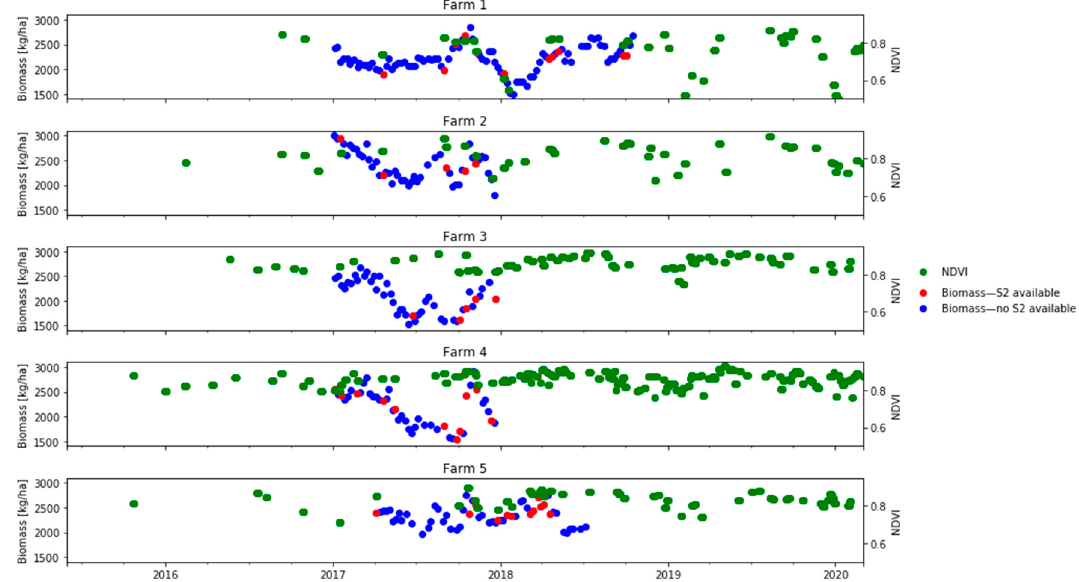
Figure 4. Availability of in situ daily biomass measurements (kg DM/ha) and S2 images at the farm level (2017–2018). Circles indicate the median biomass for all paddocks in the farm: red indicates that a corresponding S2 image was available and blue indicates that a corresponding S2 image was unavailable; green squares indicate the S2-derived median NDVIs for all paddocks in the farm.